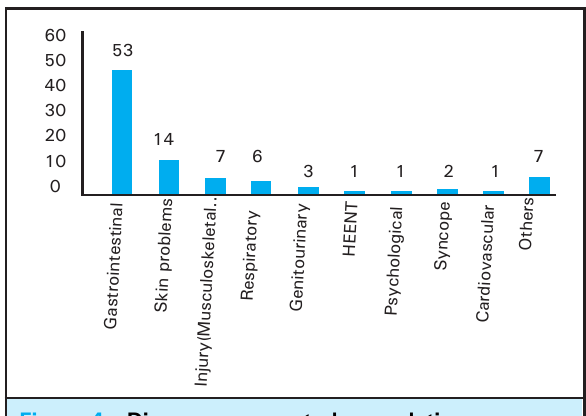
Figure 4 . Disease among study